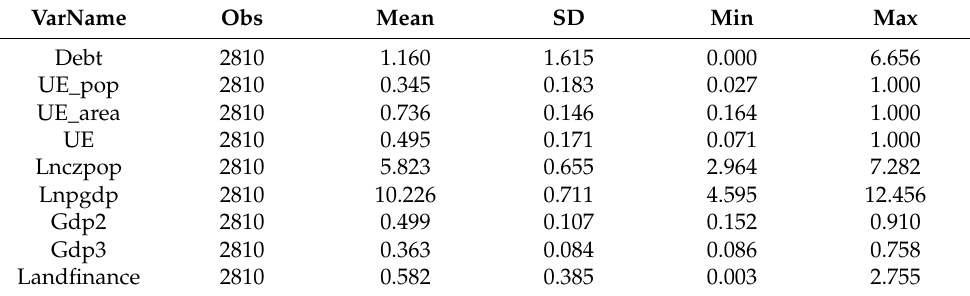
Table 2. Descriptive statistics of the main variables.